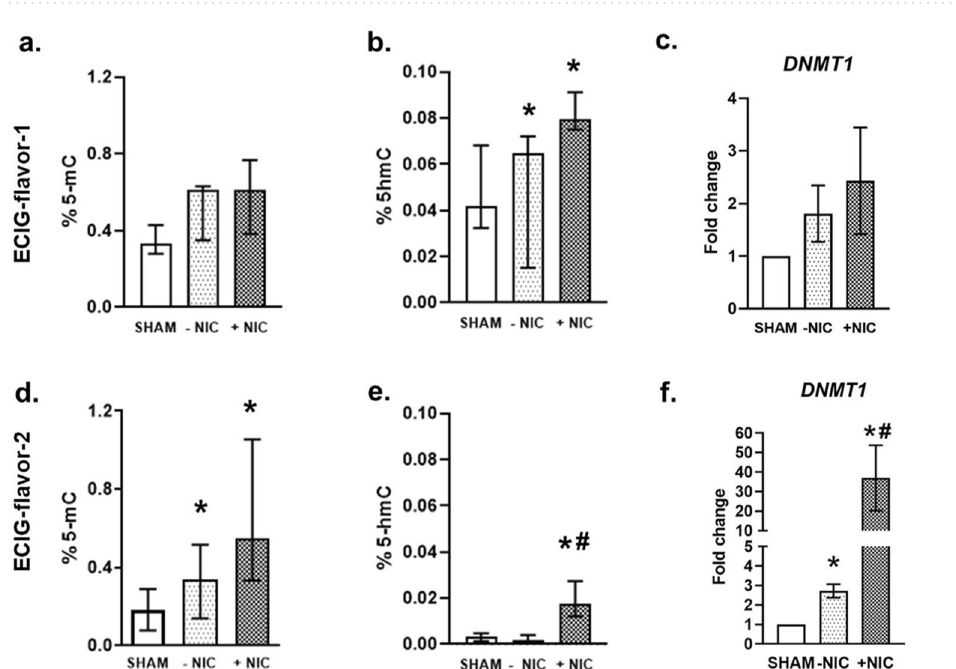
Figure 8. Methylation and hydroxymethylation of total DNA and transcript expression of DNA methyl transferase 1 ( DNMT1 ) was assessed in the alveolar mucosa model cultured at air–liquid interface following exposure to aerosolized non-nicotinized (−NIC) and nicotinized (+NIC) electronic cigarette liquid flavor 1 (ECIG-flavor-1) ( a – c ) and ECIG-flavor-2 ( d – f ). Data are shown as percentage of 5-methylcytosine (5-mC) or 5-hydroxymethylcytosine (5-hmC). Fold changes for transcript expression were calculated relative to the corresponding sham. Actin beta ( ACTB ) was used as the reference gene. *: significantly different from sham; #: significantly different from −NIC ( p < 0.05, Friedman followed by Wilcoxon